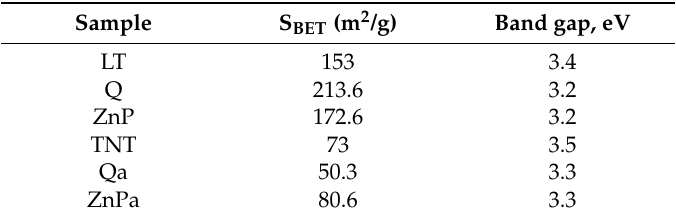
Table 1. Bandgap values and S BET of the analyzed photocatalysts. Sample